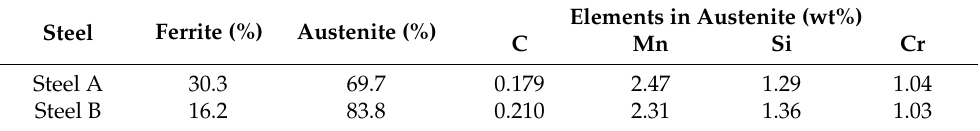
Table 6. Calculated equilibrium composition of austenite and the volume fraction of ferrite and austenite in experimental steels at 800 ◦